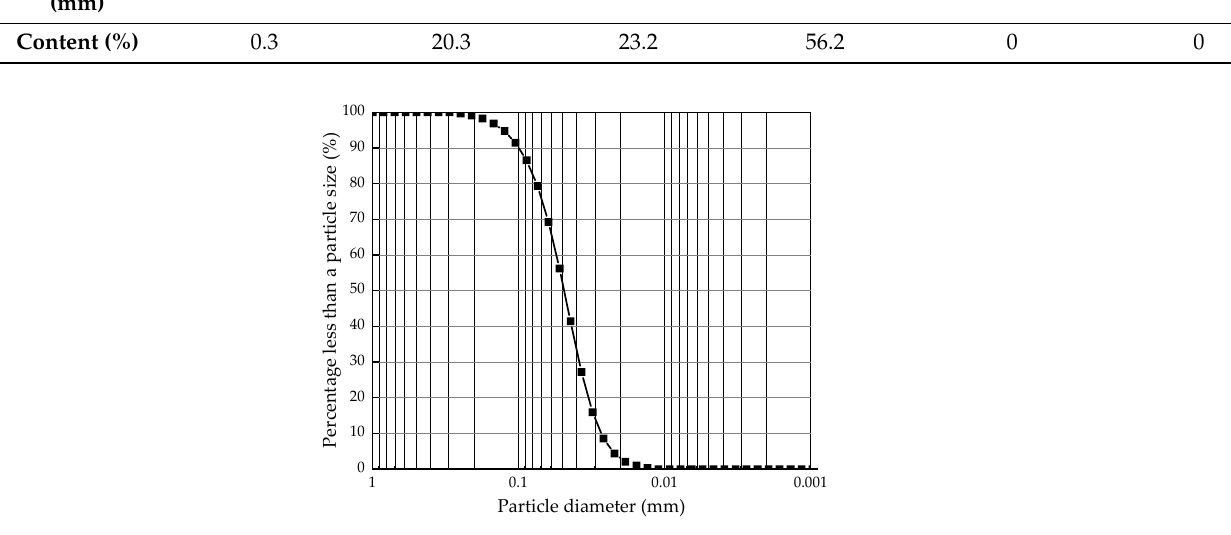
Figure 2. Particle size distribution curve of silt.